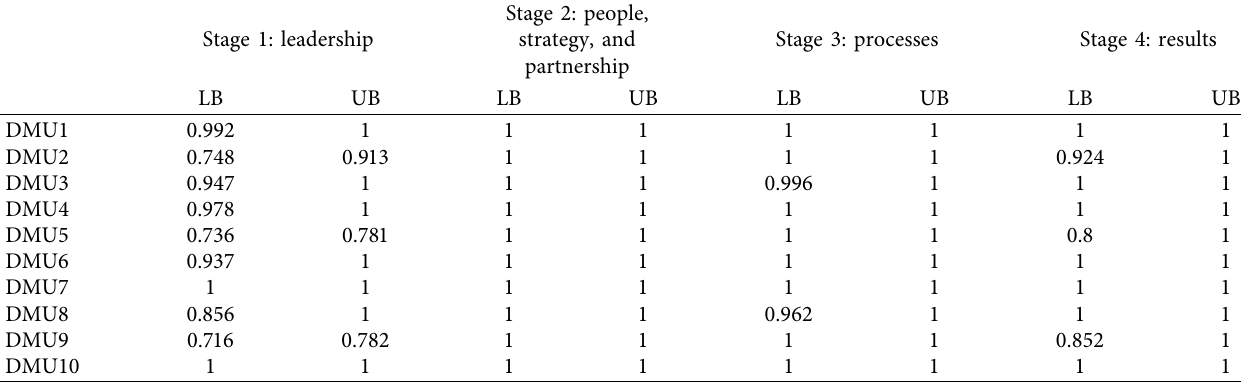
Table 4: The efficiency of EFQM stages at α �